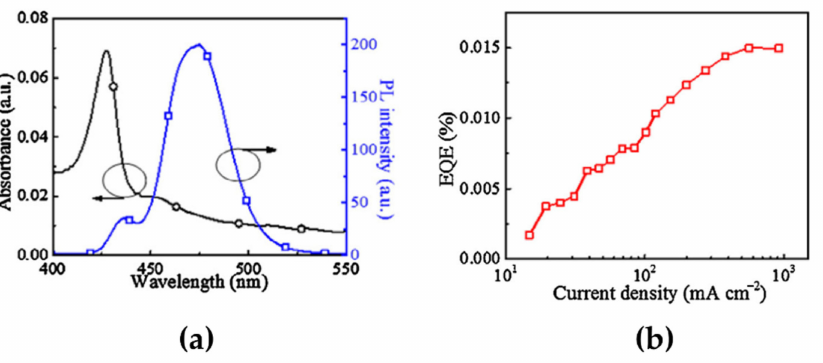
Figure 5. ( a ) Absorption (left axis) and PL spectra (right axis) of the quasi-2D PCPbB perovskite film consisting of 2D (4-PBA) 2 PbBr 4 and 3D CsPbBr 3 . ( b ) External quantum efficiencies (EQEs) as a function of current density. Reprinted with permission from [58], Copyright 2016